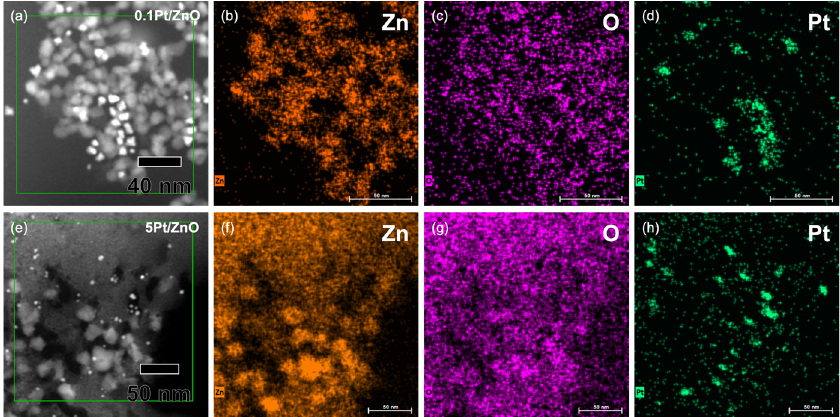
Figure 3. HAADF-STEM image of ( a ) 0.1Pt/ZnO and ( e ) 5Pt/ZnO NCs. EDS elemental mapping of ( b – d ) 0.1Pt/ZnO and ( f – h ) 5Pt/ZnO NCs. Green areas in ( a , e ) were magnified and analyzed by EDX.